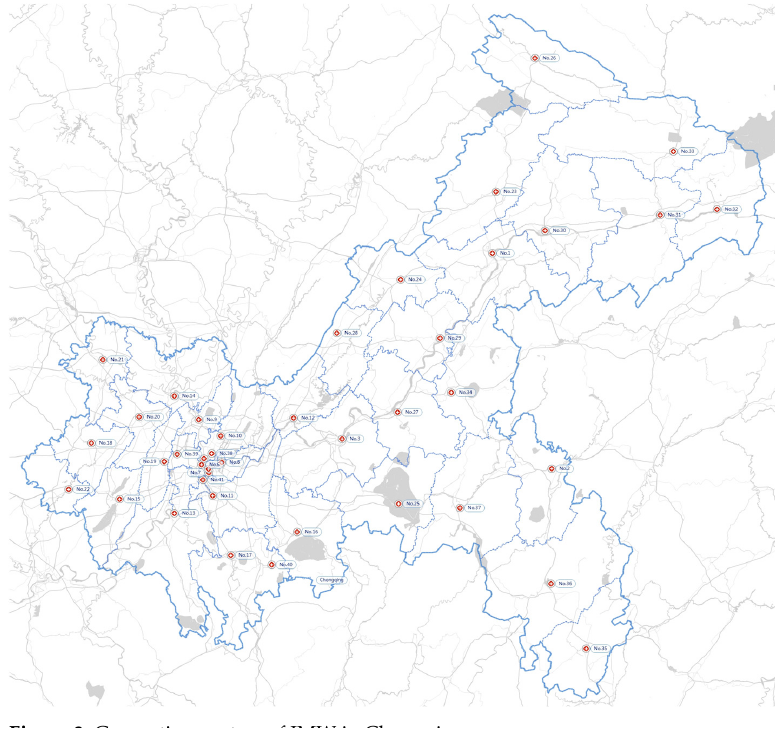
Figure 3. Generation centers of IMW in Chongqing.